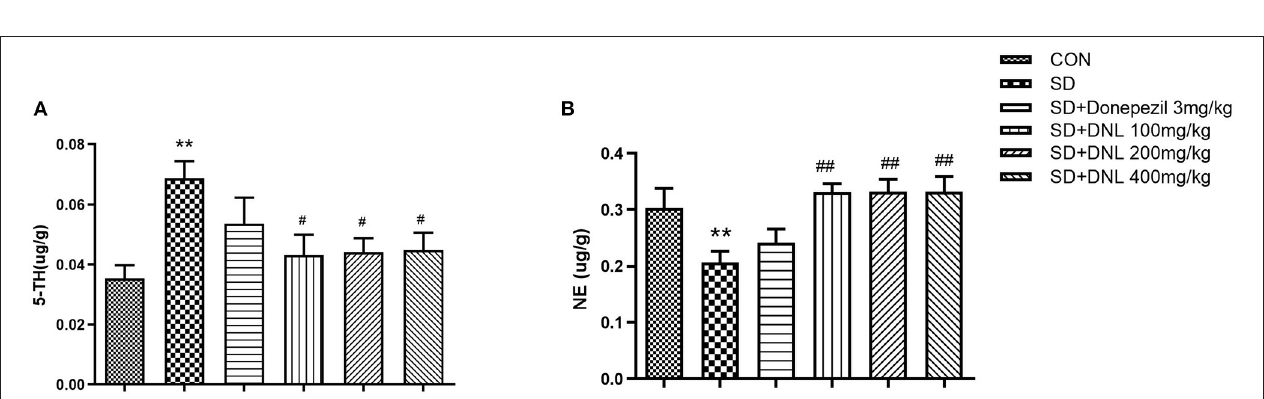
FIGURE 7 | The effect of DNL on 5-hydroxytyptamine (5-HT) (A) and norepinephrine (NE) (B) levels in the hippocampus after SD 2 weeks in mice. Values are mean ± SEM, n = 8. ** p < 0.01 vs. the Con group; # p < 0.05 vs. the SD group, ## p < 0.01 vs. the SD group.